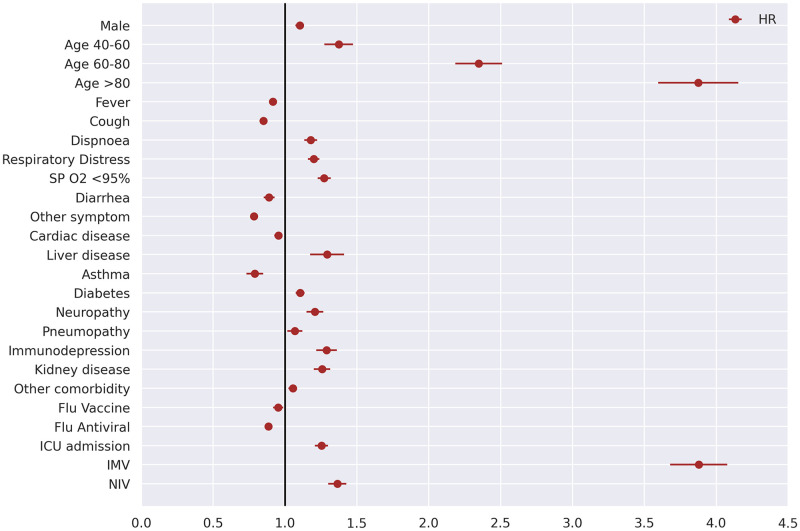
Mortality prognosis based on the general characteristics of patients in an adjusted Cox regression model (CI 95%) n = 44,128.